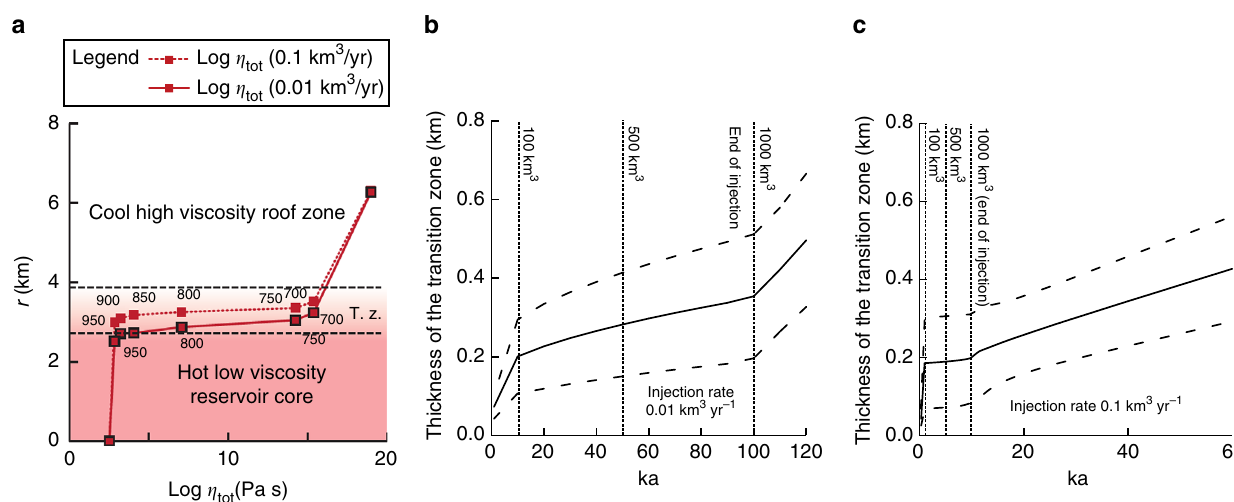
Fig. 2 Thermal models. Results of thermal models showing the variation of the temperature and magma viscosity ( η tot ) along the reservoir thickness. a The continuous and dashed lines provide the variation of magma viscosity from the top to the core of the reservoir for magma injection rates of 0.01 and 0.1 km 3 yr − 1 , respectively. The magma viscosity takes into account the effect of crystals on magma viscosity. The numbers next to the lines indicate the temperature in degrees centigrade for the corresponding value of magma viscosity. Black dashed lines represent boundaries of transition zone (T. z.). b , c Temporal evolution of the thickness of the transition zone (t.z. in a ) in the magma reservoir for magma injection rates of 0.01 km 3 yr − 1 ( b ) and 0.1 km 3 yr − 1 ( c ). Dashed lines refer to the minimum and maximum values of the transition zone (the upper limit considers a magma viscosity range of 10 4 – 10 15 Pa s, while the lower limit is for a magma viscosity range of 10 4 – 10 9 Pa